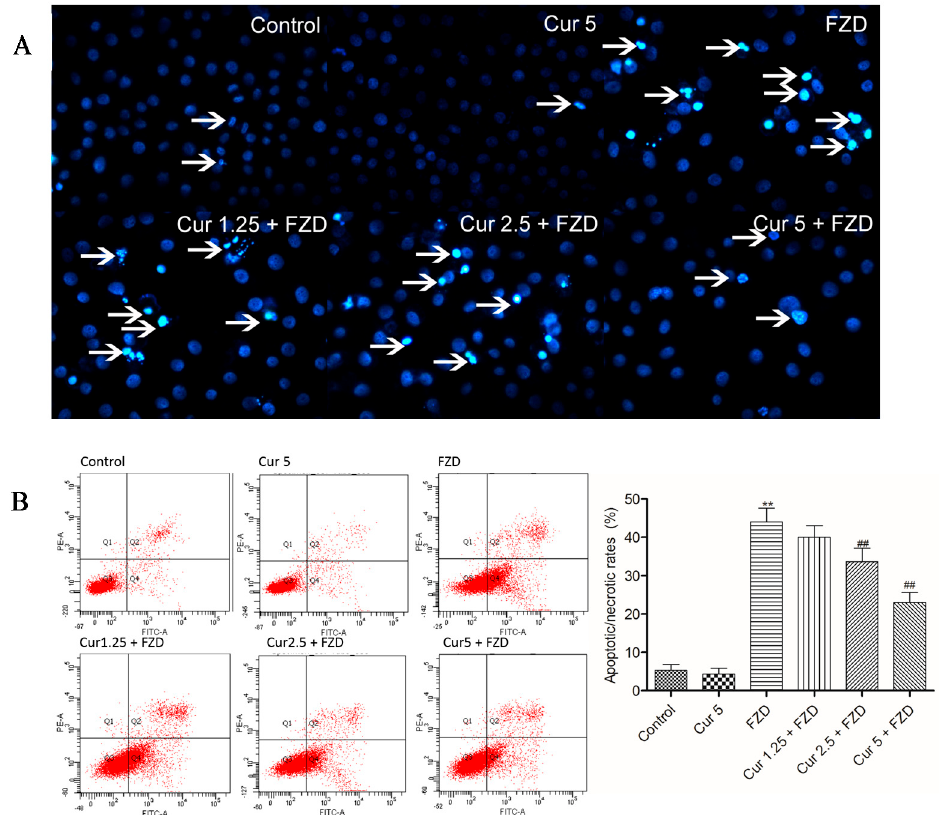
Figure 5. Curcumin treatment reduces FZD induced the apoptosis in L02 cells. L02 cells were